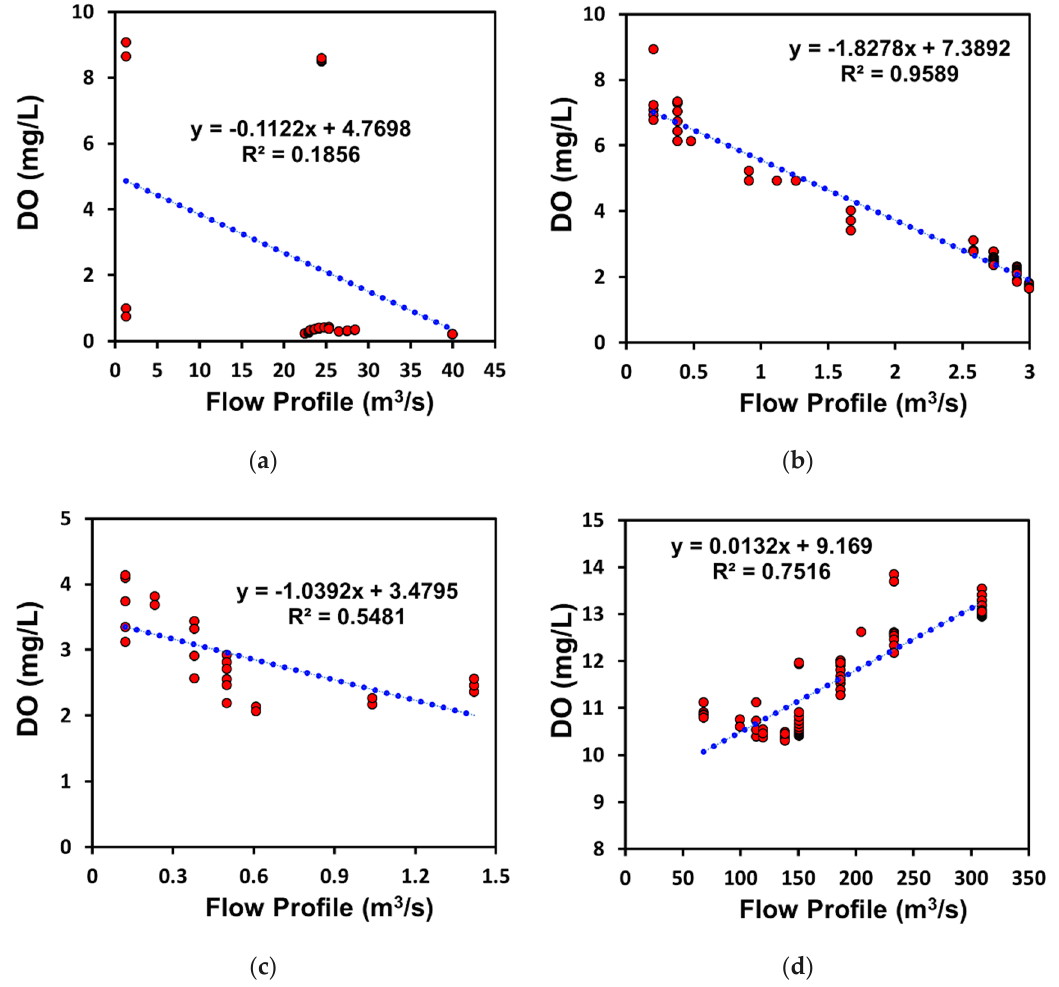
Figure 10. Dissolved oxygen concentration with respect to flow profile ( a ) Yamuna River, ( b ) Baghmati River, ( c ) Galing River, and ( d ) Nakdong River.